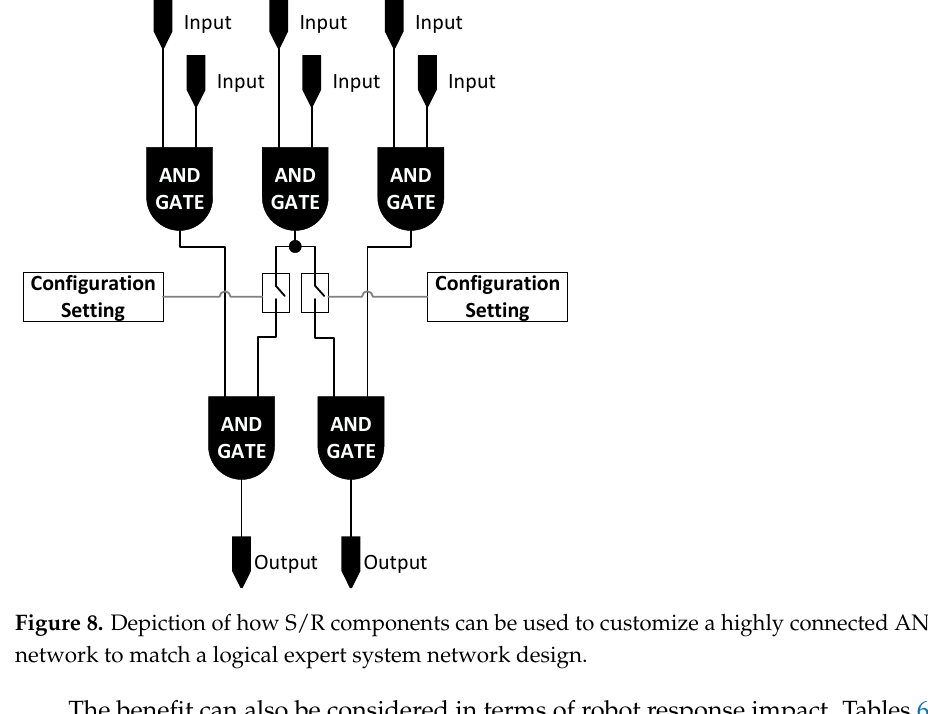
Table 6. Performance difference between hardware and software expert system networks.